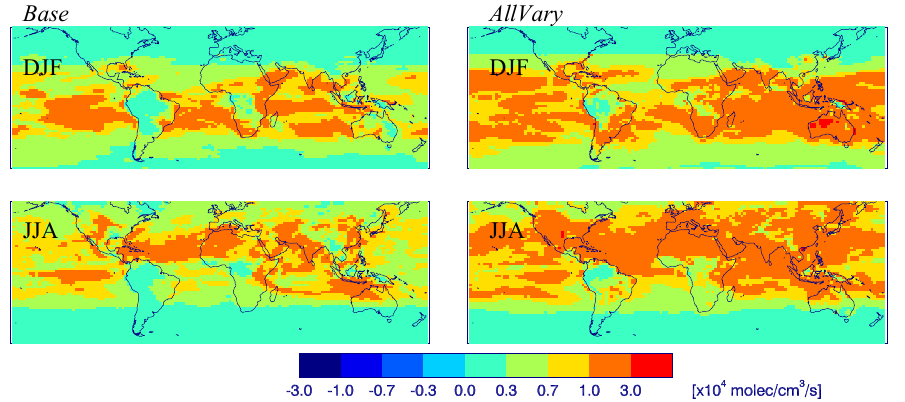
Figure 19. Seasonal mean (1988–2007) standard deviation of tropospheric methane loss rates ( × 10 4 moleculescm − 3 s − 1 ) from the Base (left column) and AllVary (right column) scenarios.